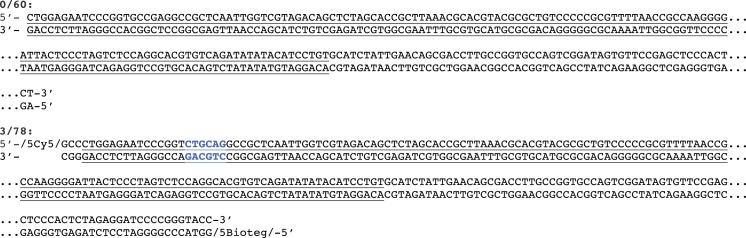
Sequences of DNA constructs used in this work.601 nucleosome positioning sequence is underlined; Pst18 restriction site (where present) is in blue. The sequence of the 3/78 construct is the same as the ‘n = 3’ construct in Blosser et al., and the 3/78 construct in Zhou et al., 2018 (Blosser et al., 2009; Zhou et al., 2018).